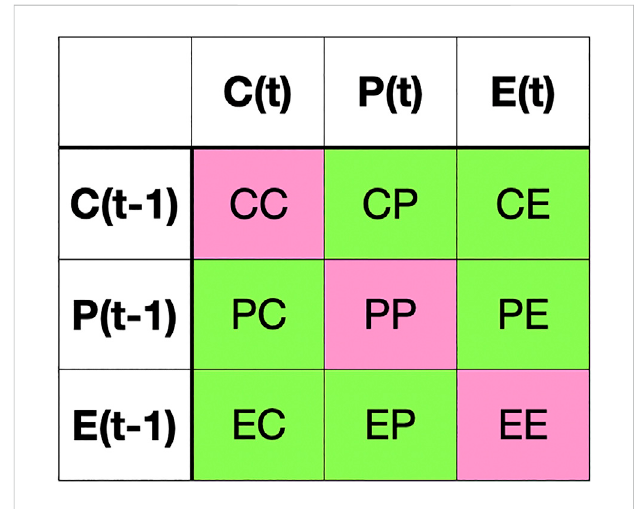
FIGURE 3 Example of D 1 and D 2 based on transition probabilities in the board network.TheCCblockshowsthetransitionprobabilityfromcore(t-1)to core (t). The PP block shows the transition probability from periphery (t- 1) to periphery (t). The EE block shows the transition probability from exit (t-1) to exit (t). D 1 is calculated as the sum of CC, PP, and EE blocks, colored in pink in this fi gure. D 2 is calculated as the sum of off- diagonal elements colored in green in this fi